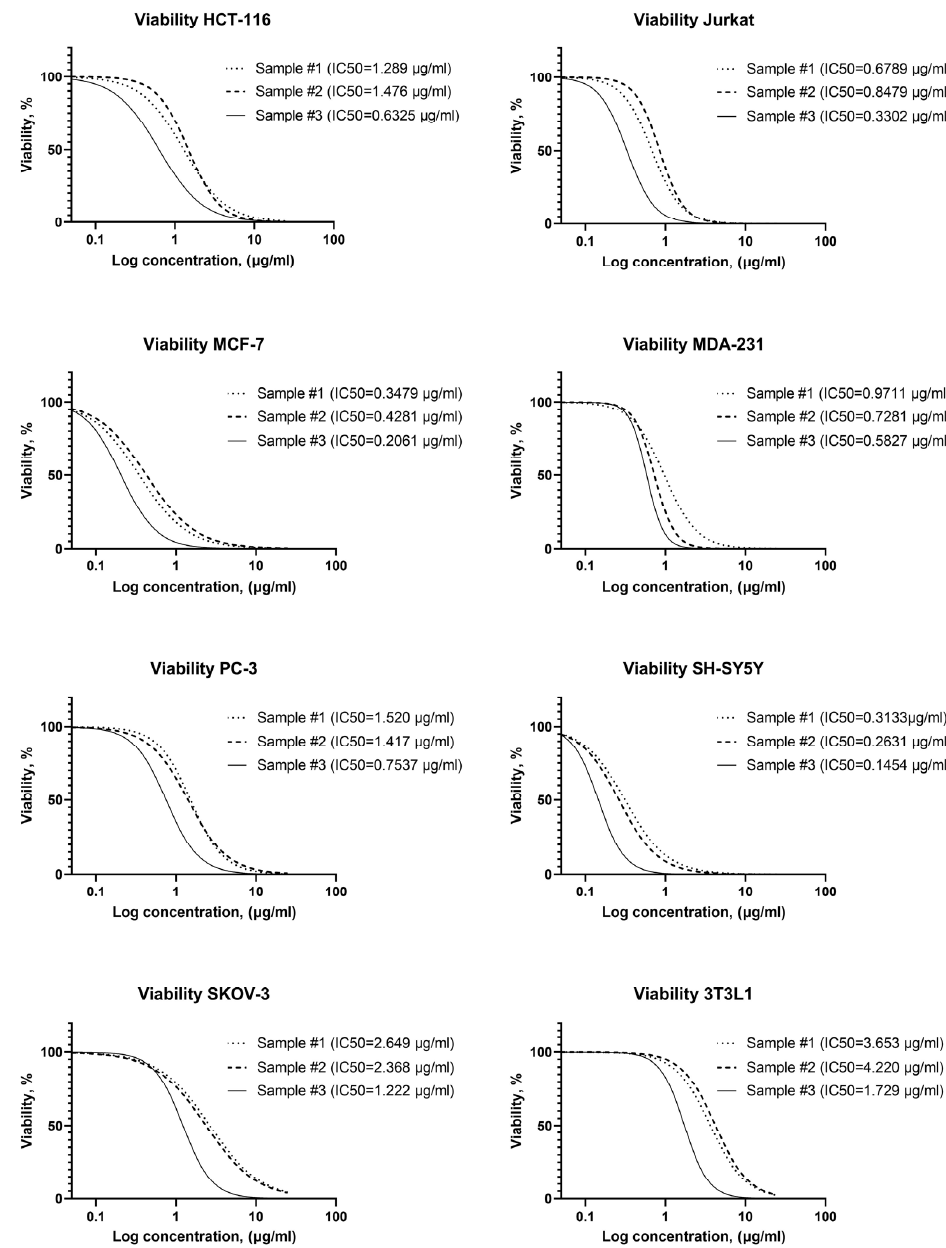
Figure 4. Dependence of cell viability vs. AgNPs concentrations with different stabilizers (AgNP samples #1–3).